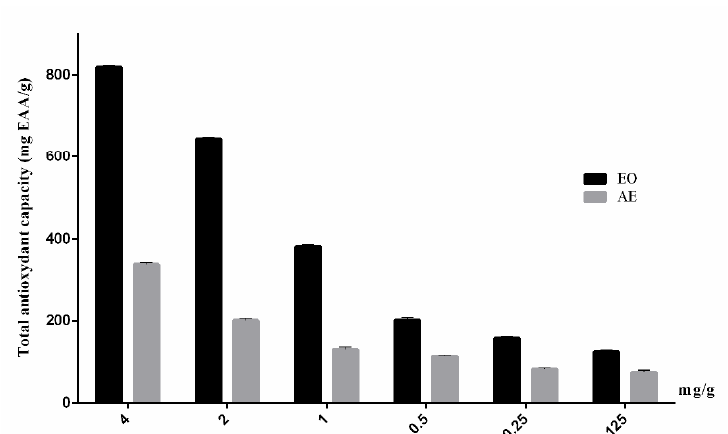
Figure 2. Total antioxidant capacity of the two tested extracts of L.